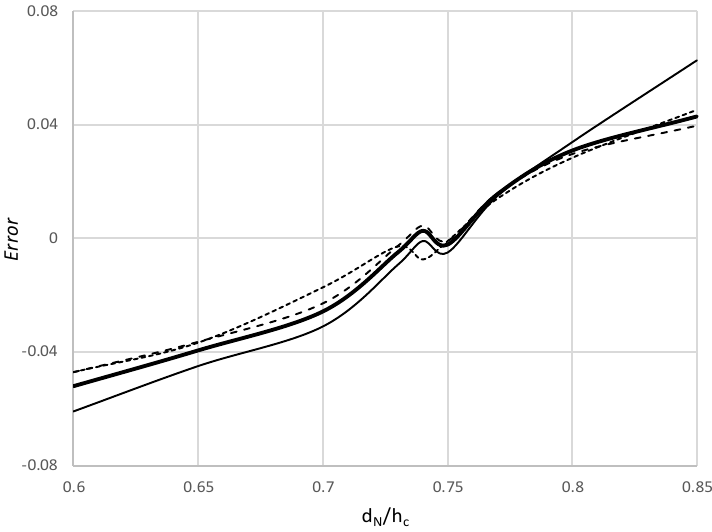
Figure 6. Error (averaged ( z 0 m / z 0 m N − 2.05 d N /d + 1.05)) for different ratios of the zero-plane displacement at neutral conditions over the canopy height in July (dotted), clear sky (thin solid) and cloudy (dashed) days in August and for all the data in August (thick solid).